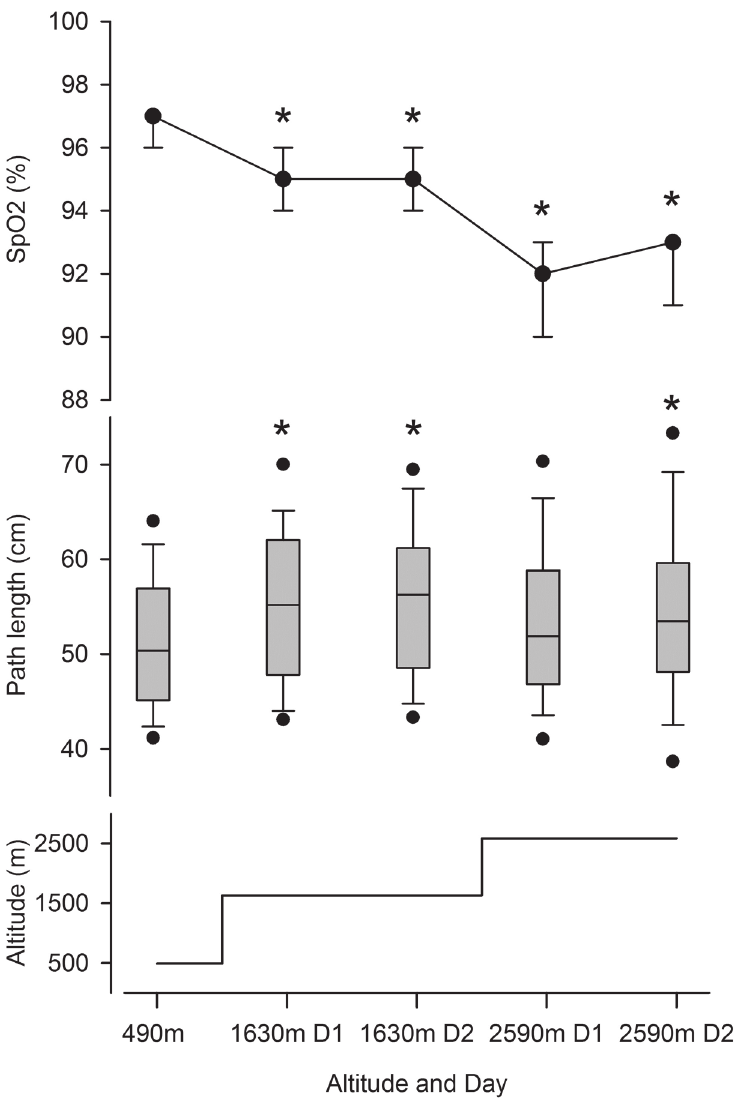
Fig 3. Results from evening measurements of arterial oxygen saturation by pulse oximetry (SpO2, medians and quartiles, top panel), and center of pressure path length by the balance board (middle panel) in the 51 study participants standing on both legs with eyes open along with altitude profile. Box plots show medians, quartiles, and whiskers representing the 10 th and 90 th percentiles, and dots the 5 th and 95 th percentiles. * p < 0.05 vs. 490 m. D1 and D2 = 1 st and 2 nd day at corresponding